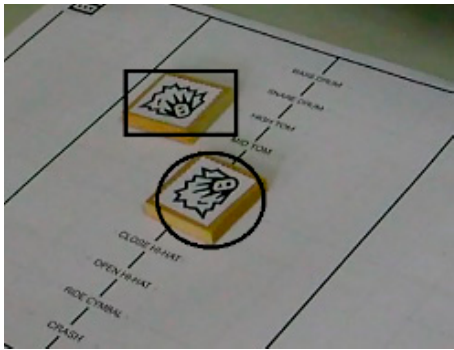
Figure 5. Block placed by Andrew (marked with circle) when asked to produce a different sound from the one produced by researcher with block marked with